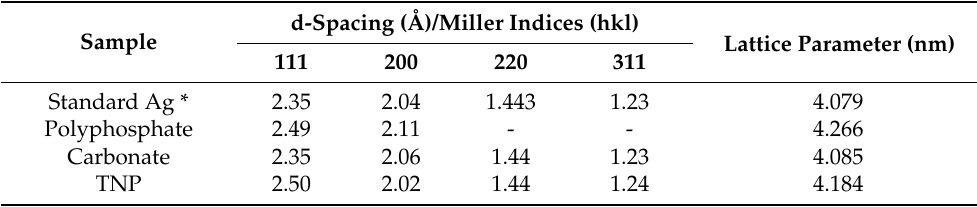
Figure 2. TEM ( a ) and HRTEM ( b ) images of a TNP; ( c ) FFT images of the area highlighted by the square in Figure 2a ( c ); Lattice fringes obtained from Figure 2c by inverse FFT ( d ); Electron diffraction pattern ( e ); Profile of d-spacing of the area highlighted in Figure 2d ( f ). Table 2. Comparison of interplanar spacing as determined by electron diffraction of the Ag NPs.